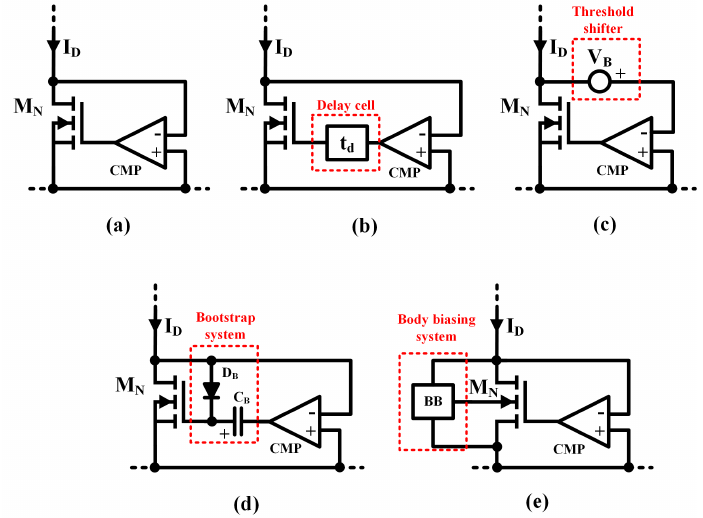
Figure 11. Simplified block diagrams of modified active diodes: conventional ( a ), with improved turn-on instant and conduction angle by means of delay cell ( b ) and threshold voltage shifting ( c ), bootstrapped ( d ) and body biased ( e ).